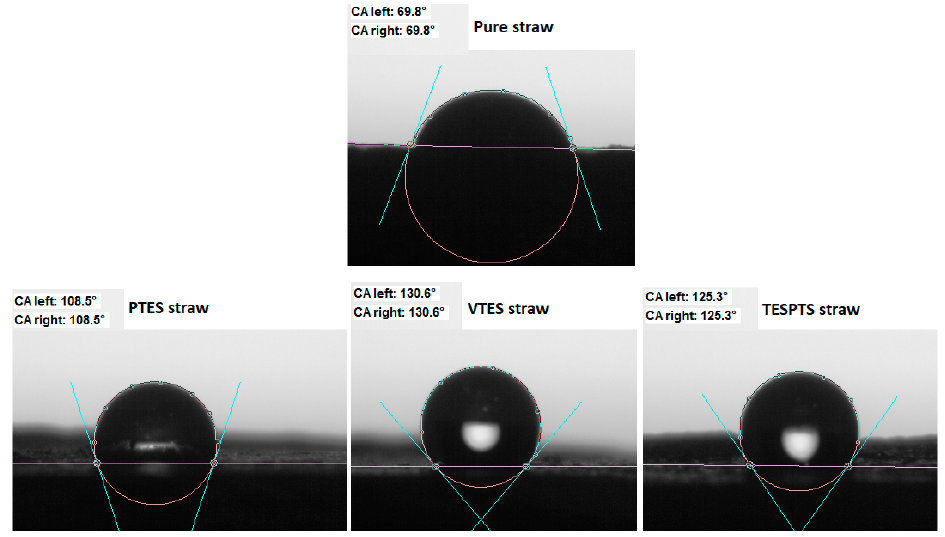
Figure 4. Images of drops on the surface of pure and silanized straw. CA—contact angle.